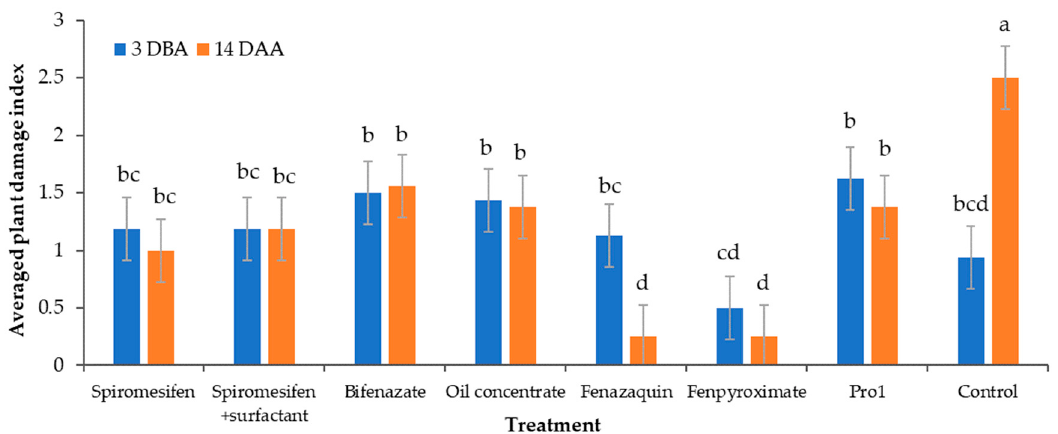
Figure 3. Bronzing of blueberry foliage caused by southern red mite feeding. Ratings taken pre-treatment 3 days before the 1st miticide application (3-DBA, on 9/20/19) and 14 days after the second and final miticide application (14-DAA, on 10/22/19) based on an arbitrary plant damage index (0 = no bronzing; 1 = 1% ≥ 25% (low bronzing); 2 = 26% ≥ 50% (moderate bronzing); 3 = 51% ≥ 75% (high bronzing); and 4 = 76% ≥ 100% (severe bronzing) bronzed foliage). Different letters across bars indicate significant differences (Treatment*Sampling event interaction, F 7, 237 = 3.63; p = 0.001).